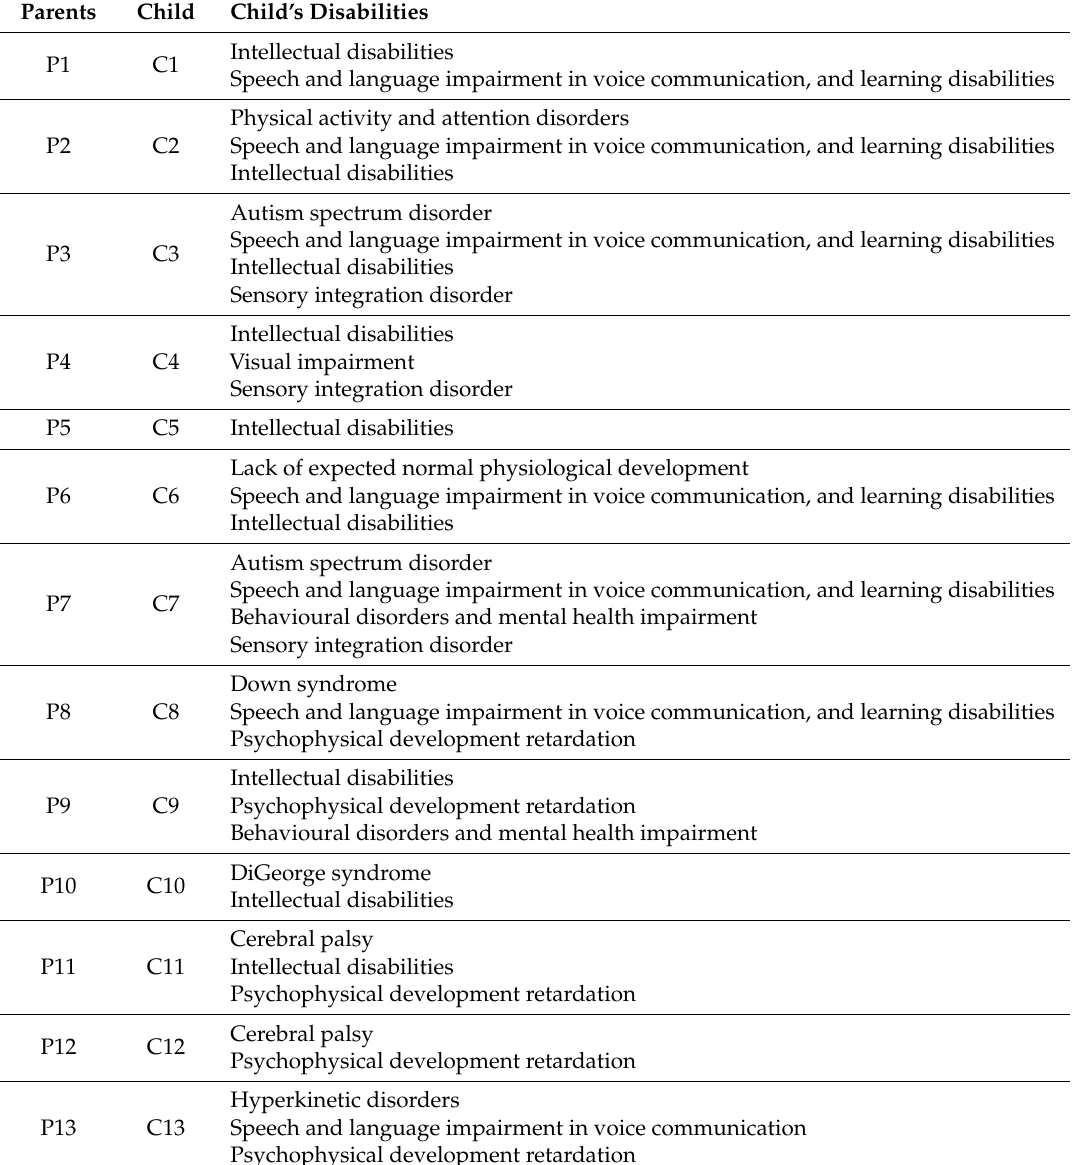
Table 2. General data on the